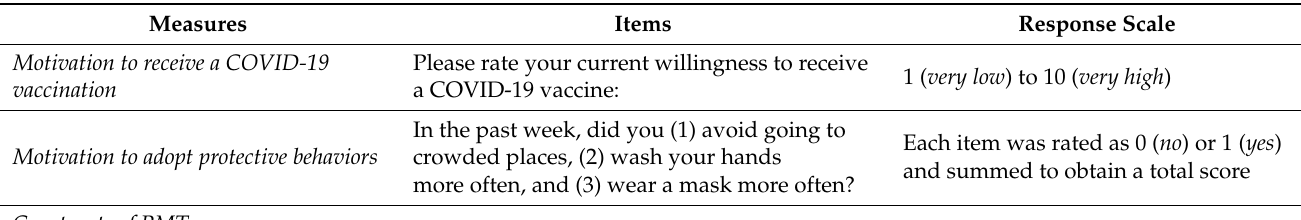
Table 1. Motivation to Receive a COVID-19 Vaccination with Related Constructs of the Extended PMT.